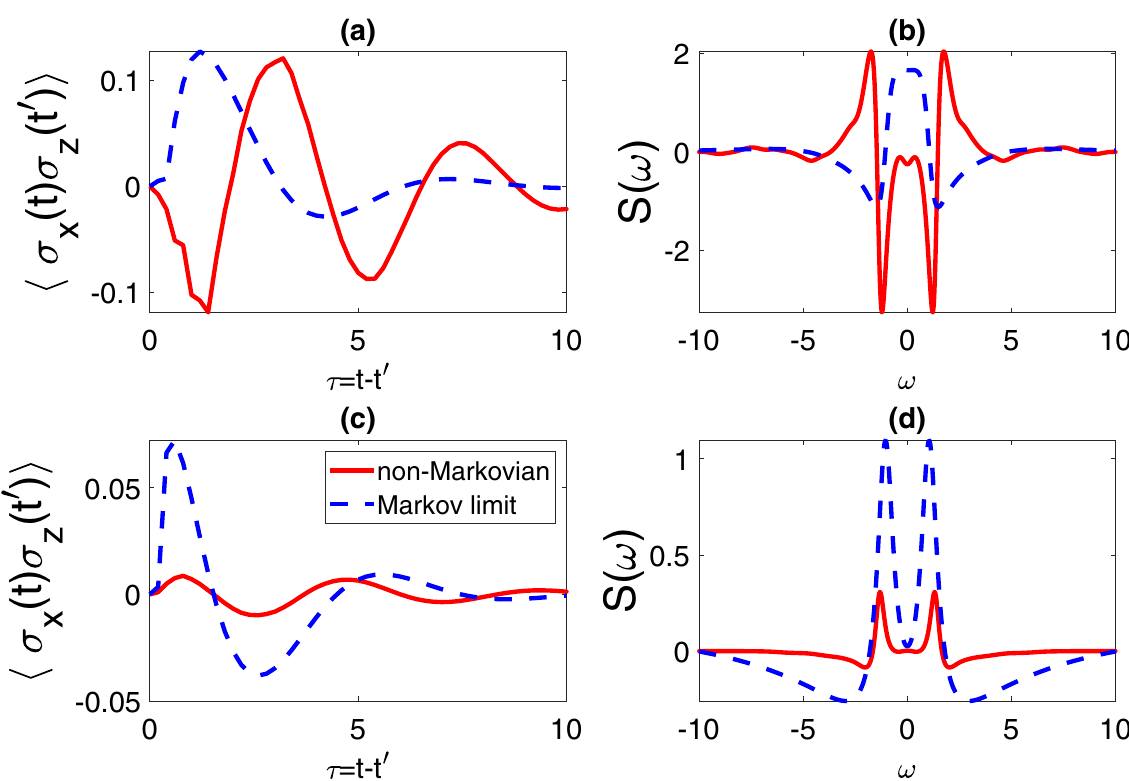
σ x ( t )σ z ( t ′ ) , with two initial � �